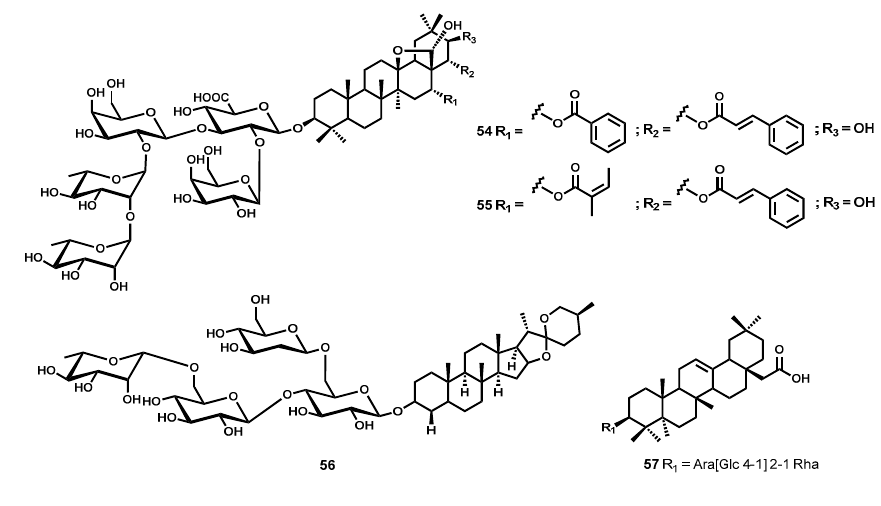
Figure 9. Anti-leishmanial saponins.